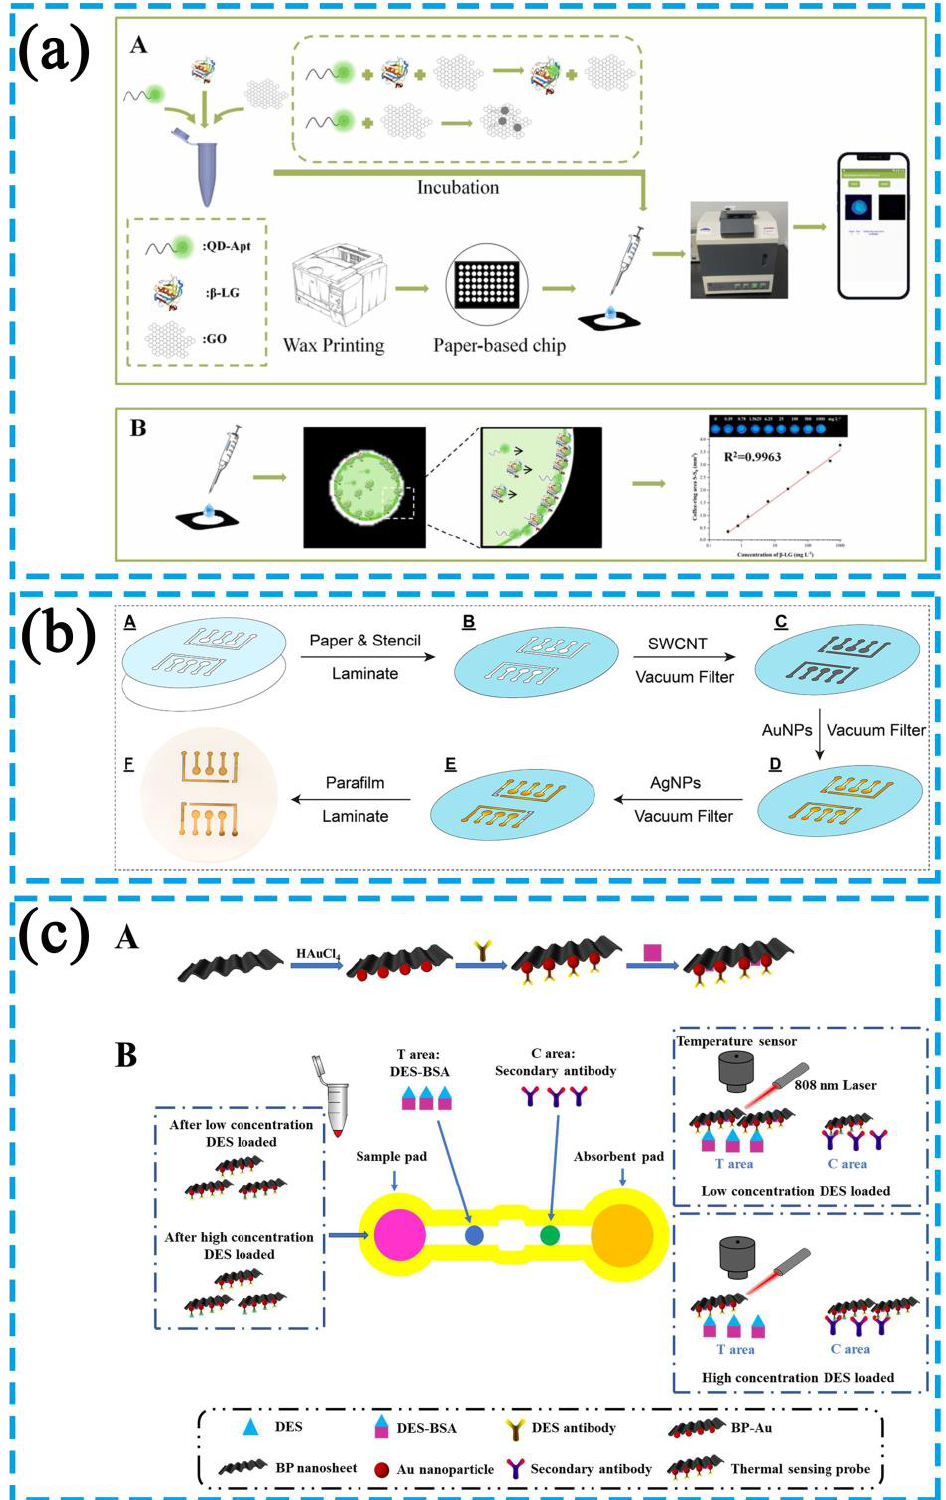
Figure 5. ( a ) Diagram of a fluorescence resonance energy transfer (FRET)-based biosensor. Reprinted with permission from Ref. [71]. Copyright 2023, Elsevier B.V. ( b ) Diagram of a rapid detection method of cancer cells by the photothermal effect of GO in permeabilized test strips (DFA). Reprinted with permission from Ref. [72]. Copyright 2021, American Chemical Society. ( c ) Diagram of a photothermal-sensing microfluidic paper-based analytical chip (PT-Chip). Reprinted with permission from Ref. [76]. Copyright 2023, Elsevier B.V.